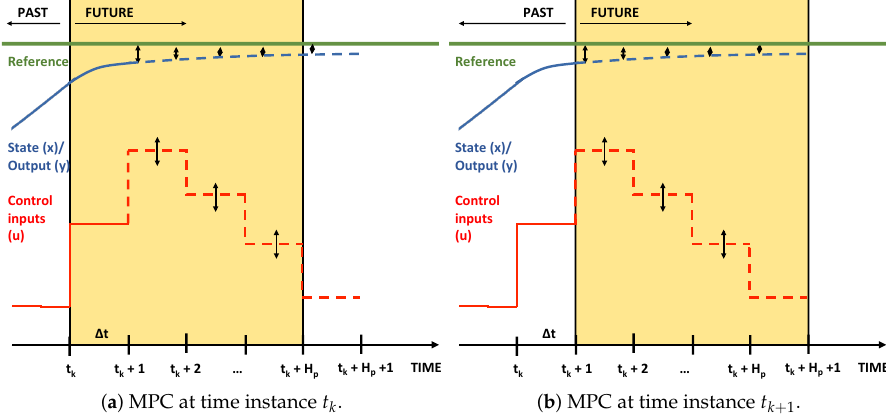
Figure 2. Illustration of two consecutive MPC